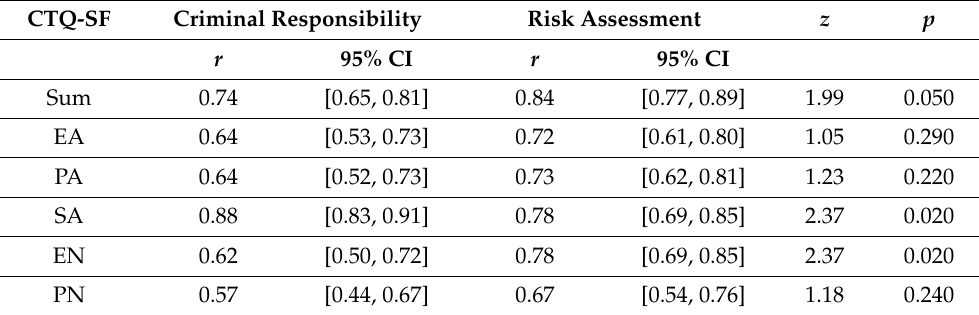
Table 8. Comparison of Pearson Correlation Coefficients of CTQ Self-Assessment and External Assessment between the Criminal Responsibility ( n = 131) and Risk Assessment ( n = 100) Groups. CTQ-SF